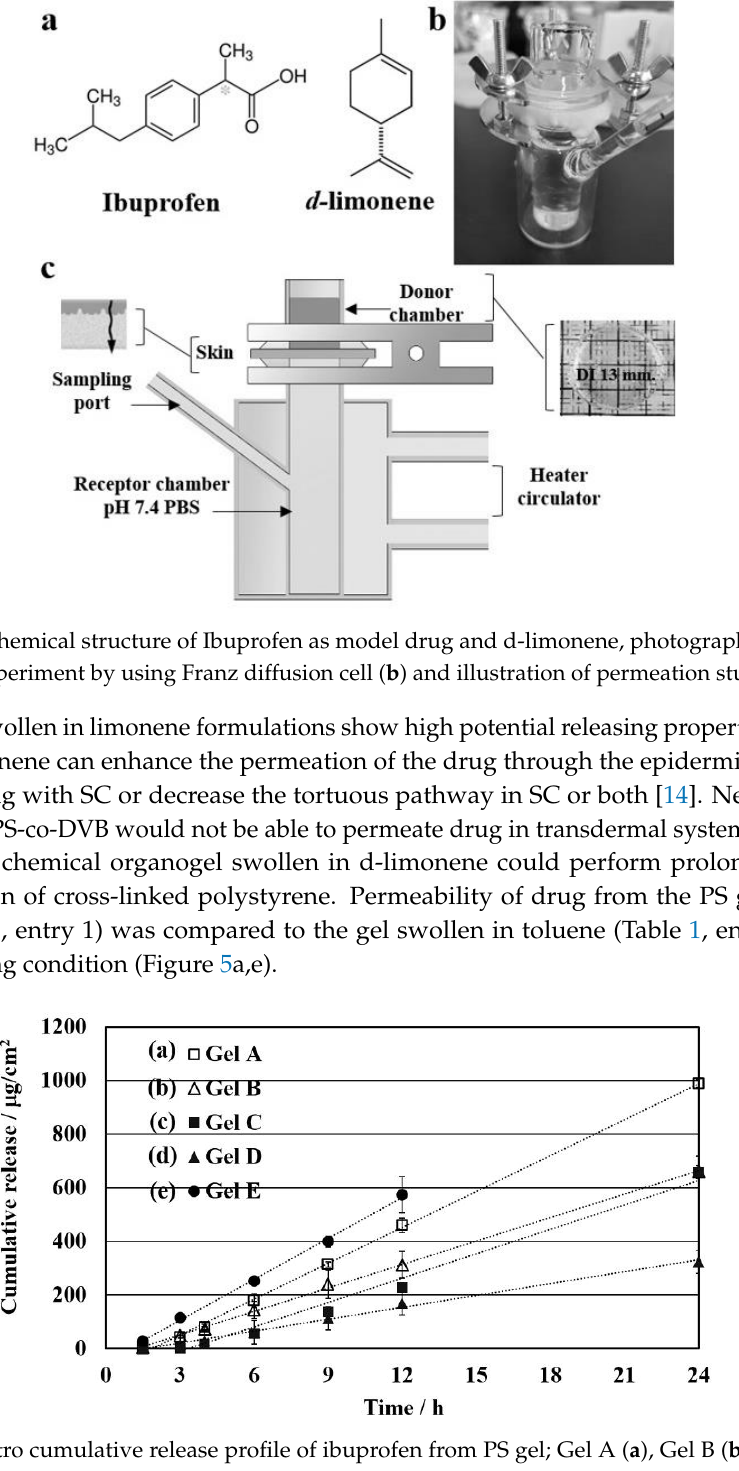
In order to investigate the drug permeation as a controlled release by the cross-linked PS gel swollen in limonene, ibuprofen was selected as a model drug (Figure 4). The drug was released through the rat skin into the receiver solution of pH 7.4 PBS at 37 ◦ C using a Franz diffusion cell as shown in Figure 4c.